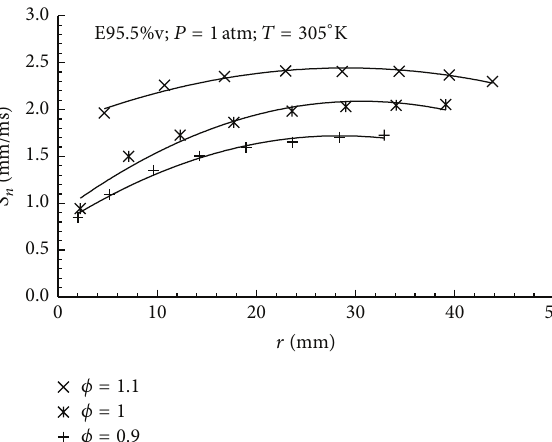
Figure 8: Flame speed versus the flame radius in lean, stoichiomet- ric, and rich mixtures.